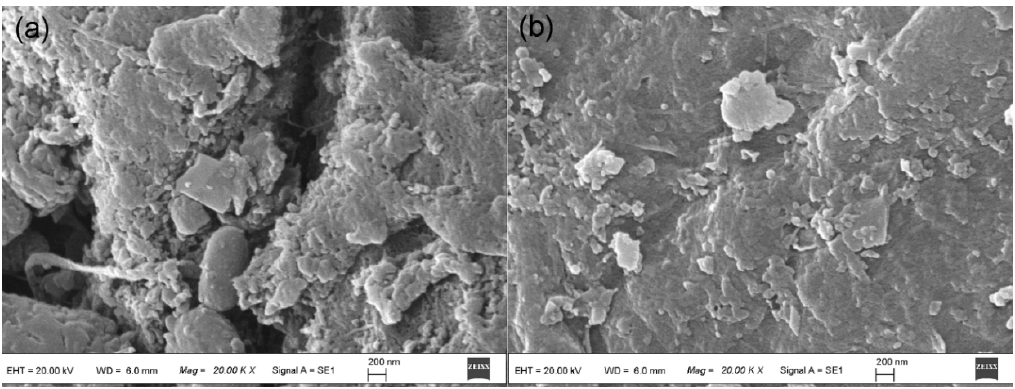
Figure 1. SEM images of the biosorbents, ( a ) HGP and ( b ) MGP.